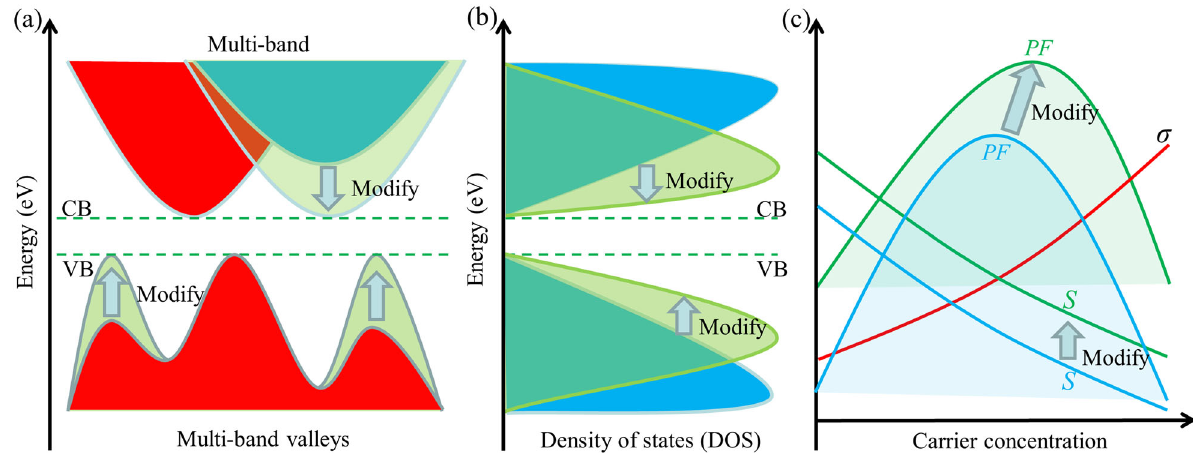
Fig. 1 Electronic band structure engineering. The modi fi cation of band valleys ( a ), density of states ( b ) and power factor ( c ) for layered oxyselenides by electronic band structure